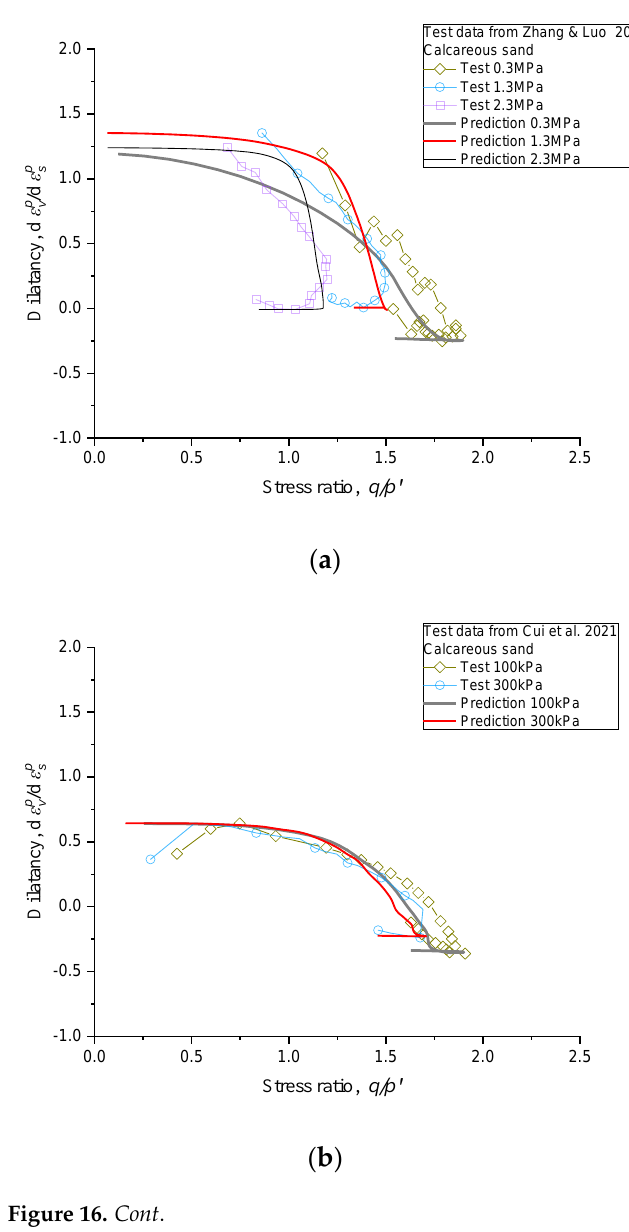
Figure 15. Comparison of predictions of volumetric strain: ( a ) p  = 600 kPa. and ( c ) 0